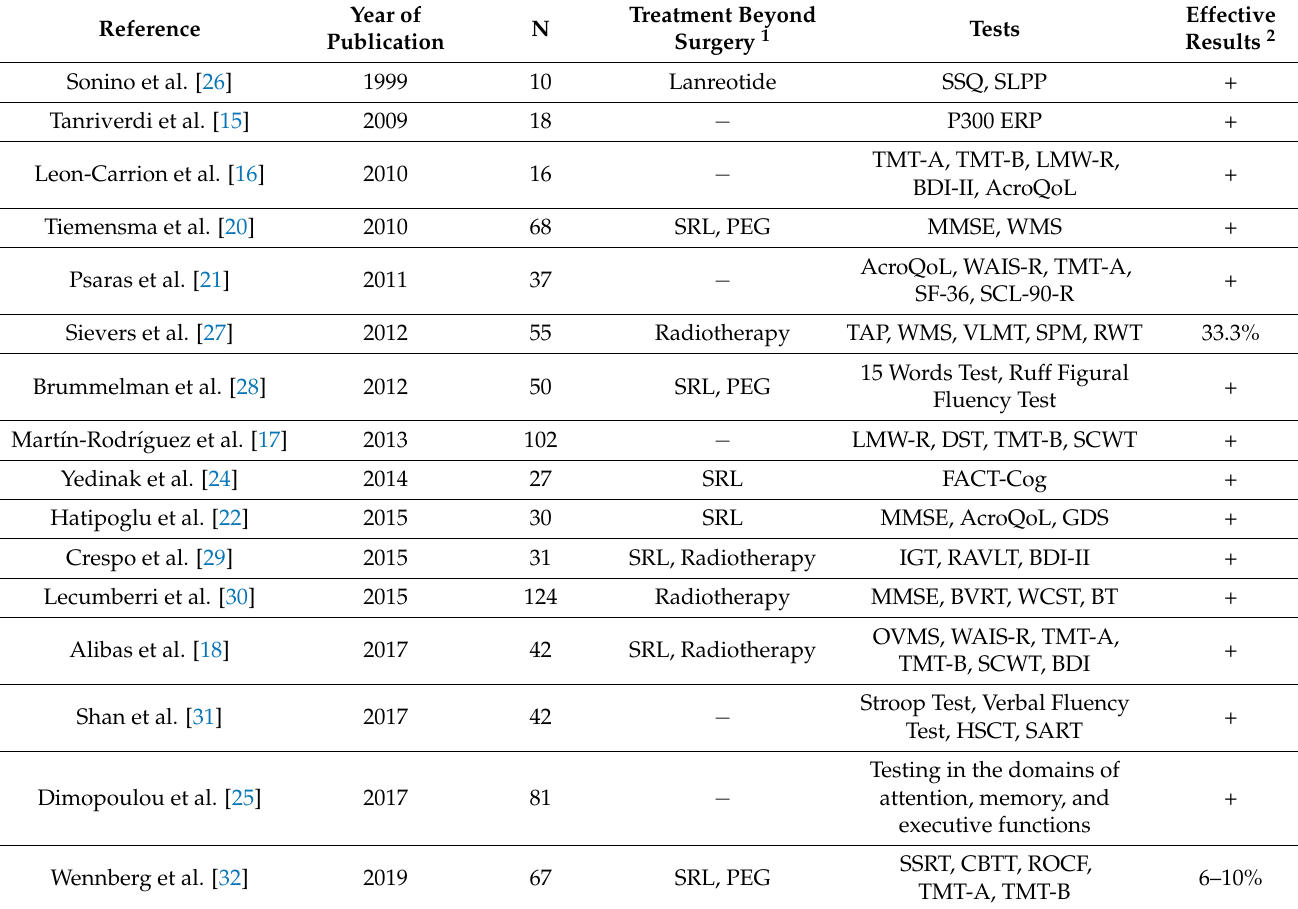
Table 1. Neuropsychological tests to assess cognitive function in patients with acromegaly.